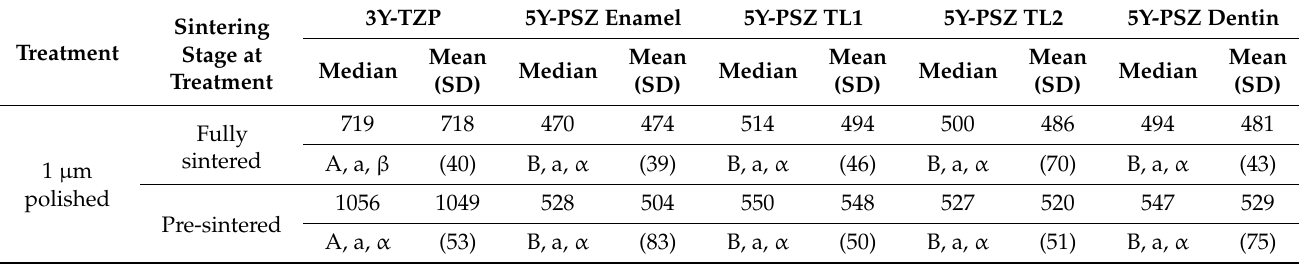
Table 4. Medians, means and standard deviations (SD) in MPa of the biaxial flexural strength of test groups (N = 10) measured with piston-on-three-balls test. Statistically different medians ( p ≤ 0.05) are indicated by different upper-case letters (within a column for analysis of the different materials with the same surface treatment), or by subscript lower-case letters (within a row for the same ma- terial with different surface treatment), or by different lower-case Greece letters (comparison of the cutting before and after sintering).